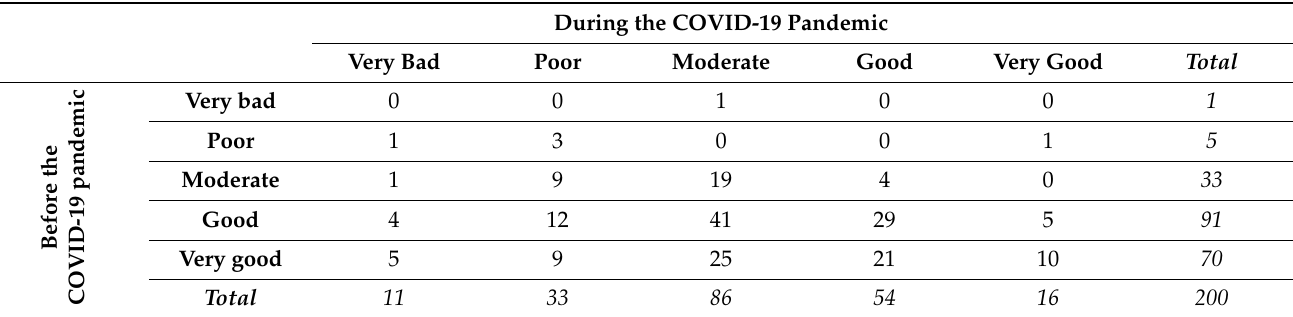
Table 2. The change in the respondents’ sense of well-being before and during the COVID-19 pandemic. During the COVID-19 Pandemic Very Bad Poor Moderate Good Very Good Total